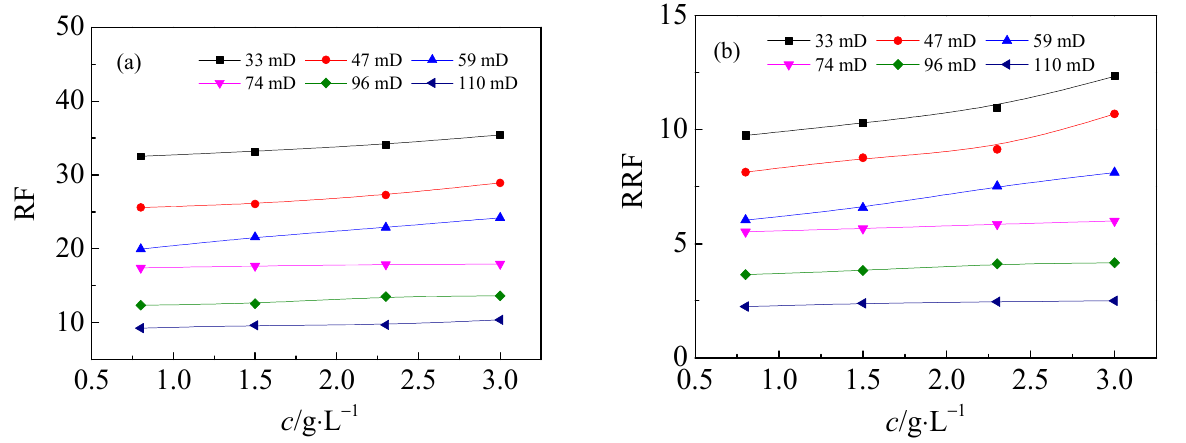
Figure 5. The dependence of ( a ) the resistance factor (RF) and ( b ) the residual resistance factor (RRF) for LW-HPAM solution on the concentration in different permeability cores.